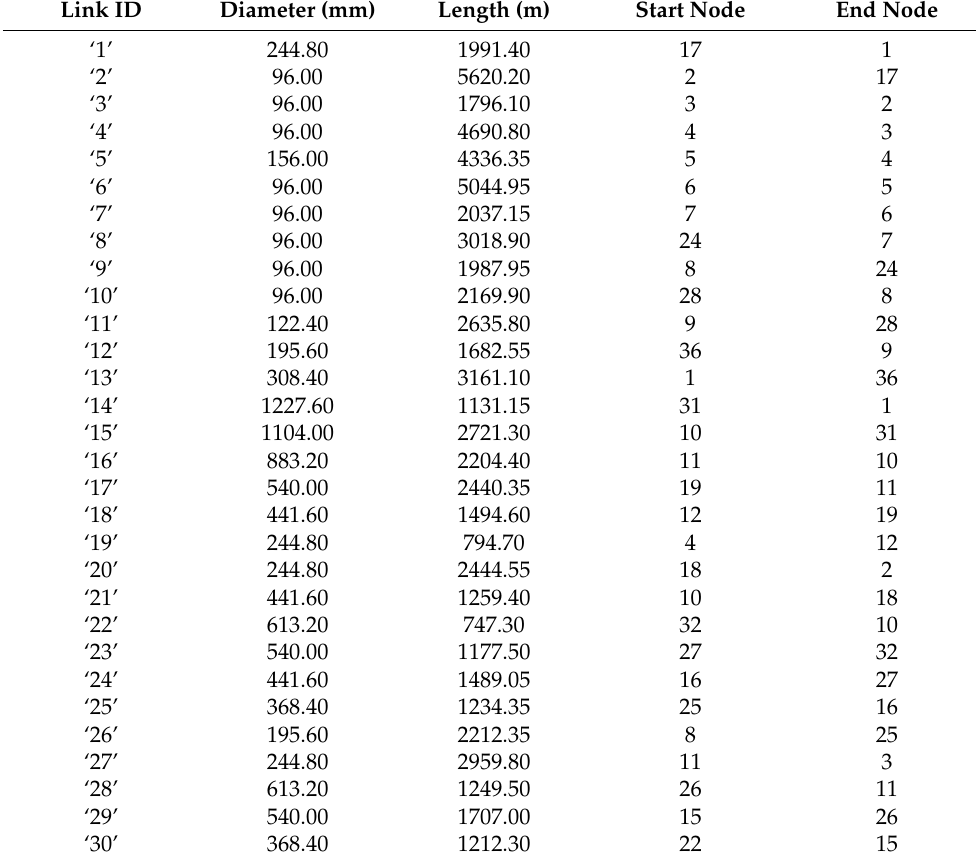
Table 1. Fossolo network—link